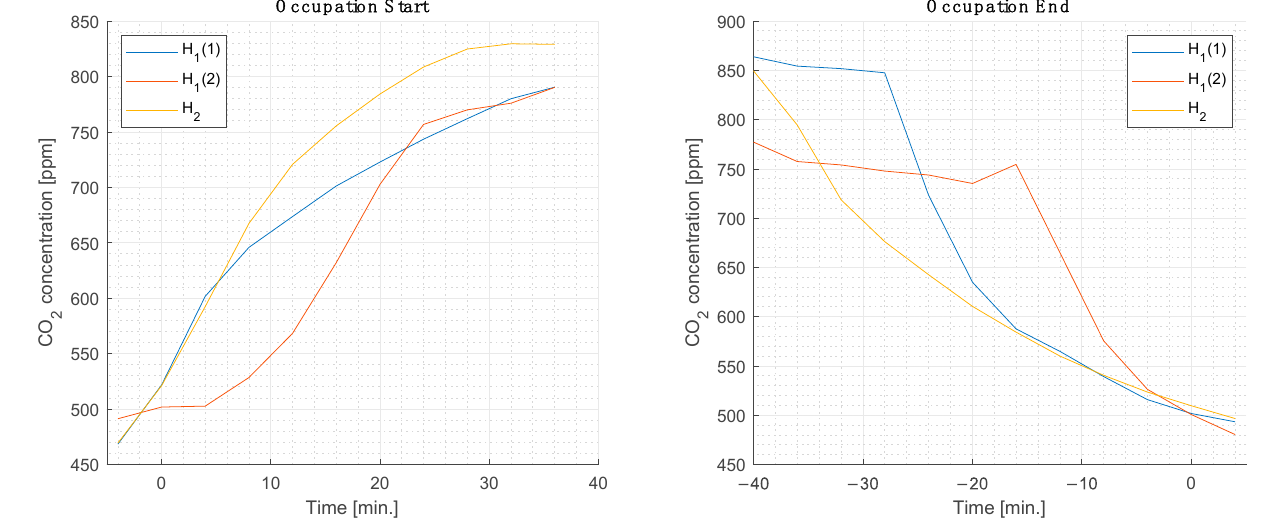
Figure 15. Rise and decay of CO 2 concentration during room population and emptying phases.